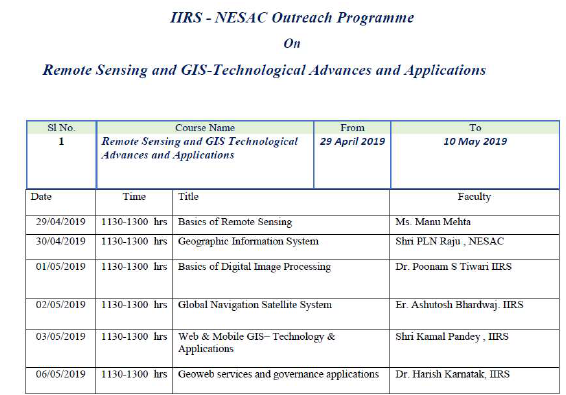
Figure 4. A part of NESAC- IIRS Joint course schedule